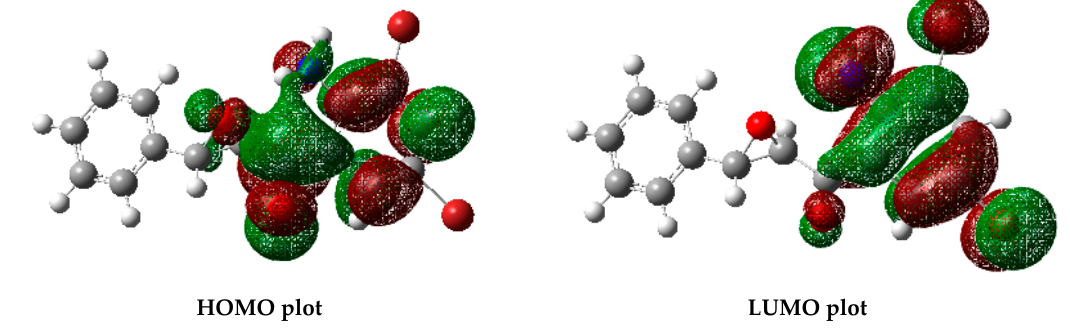
Figure 9. HOMO–LUMO distribution of 2a .